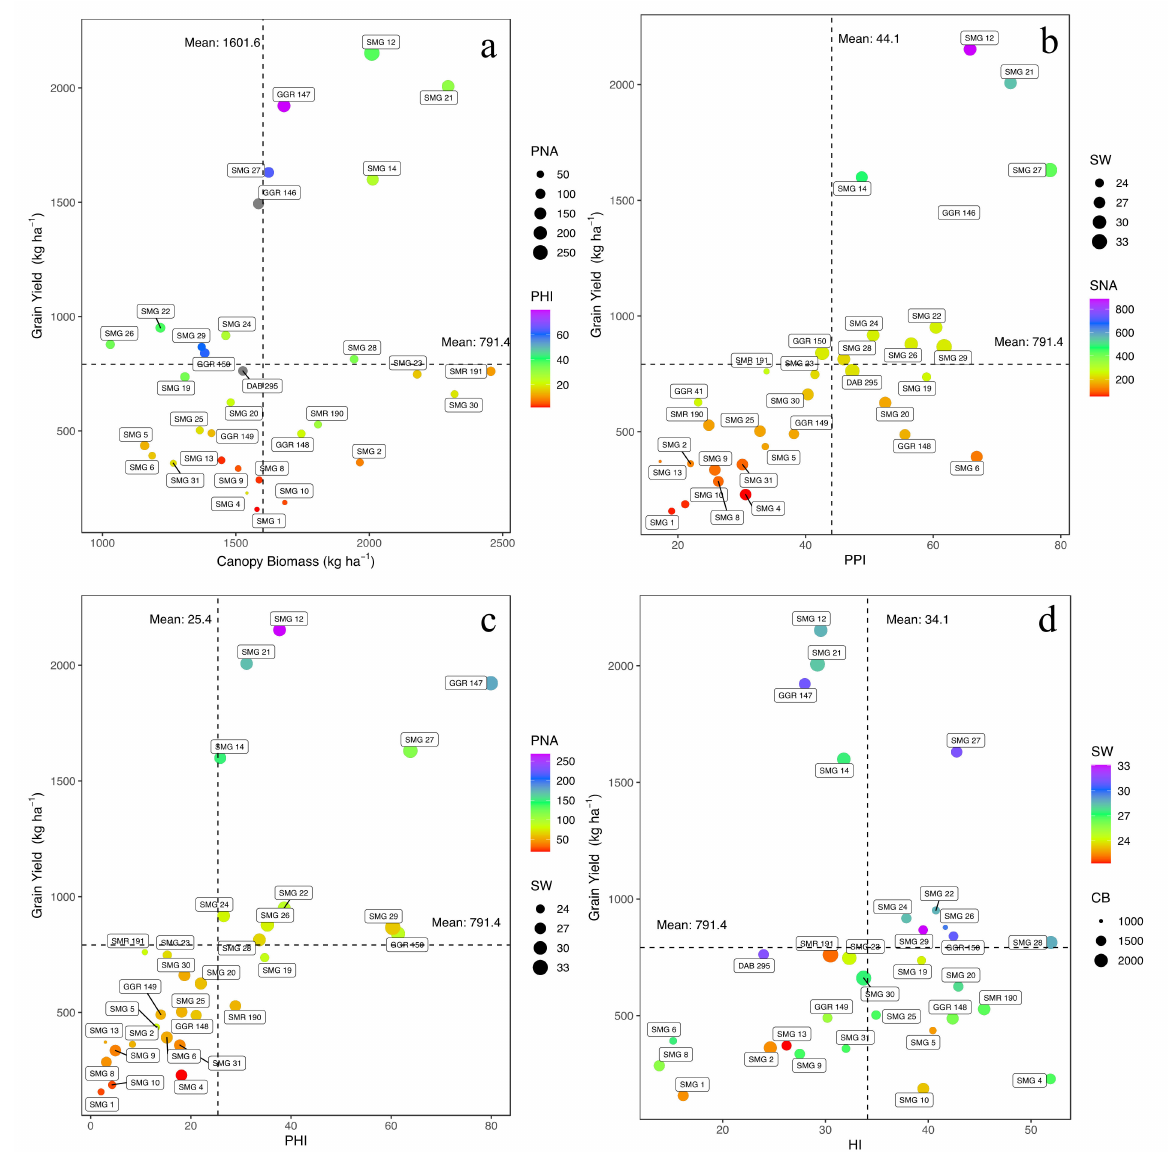
Figure 1. Relationship between grain yield (GY) and different biomass partitioning indices as a function of gradient (change in the color of violet and red from higher to lower value) and magnitude (size of the circle), of parameters that affect the response variable. The dotted lines on the axes correspond to the means of the dependent and independent variables. ( a ) Grain Yield (GY) and Canopy Biomass (CB) as a function of Pod Harvest Index (PHI) and Pod Number Area (PNA). ( b ) Grain Yield (GY) and Pod Partitioning Index (PPI) as a function of Seed Number Area (SNA) and Seed Weight (SW). ( c ) Grain Yield (GY) and Pod Harvest Index (PHI) as a function of Pod Number Area (PNA) and Seed Weight SW. ( d ) Grain Yield (GY) and Harvest Index (HI) as a function of Seed Weight (SW) and Canopy Biomass